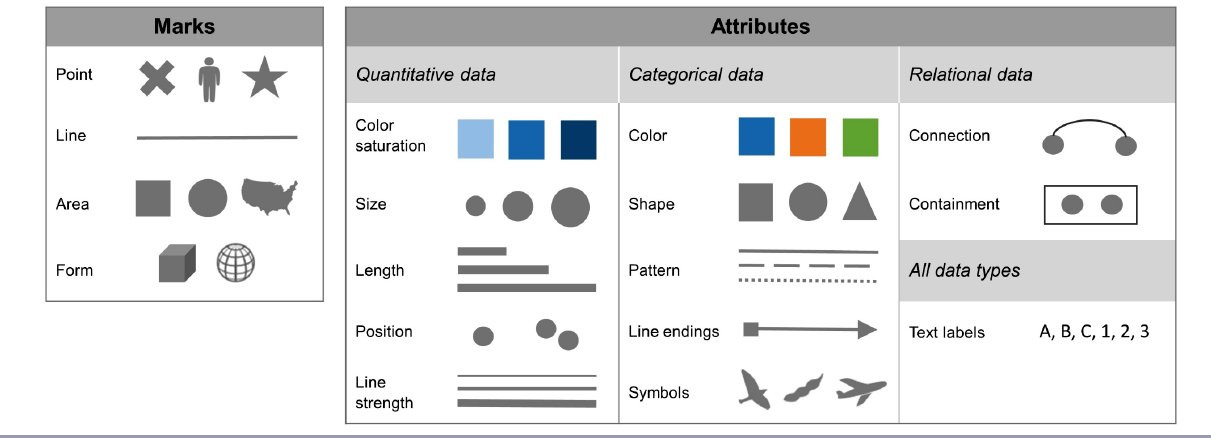
Fig. 1 . A selection of visual mark and attribute encodings. Source: Authors, adapted from Iliinsky and Steele (2011) and Kirk (2016).